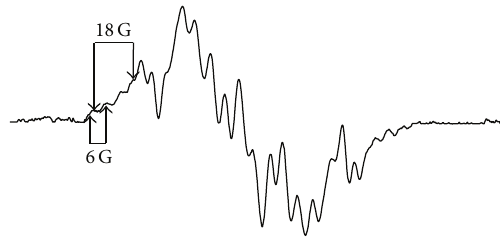
Figure 2: ESR spectra of 100 kGy pristine UHMWPE